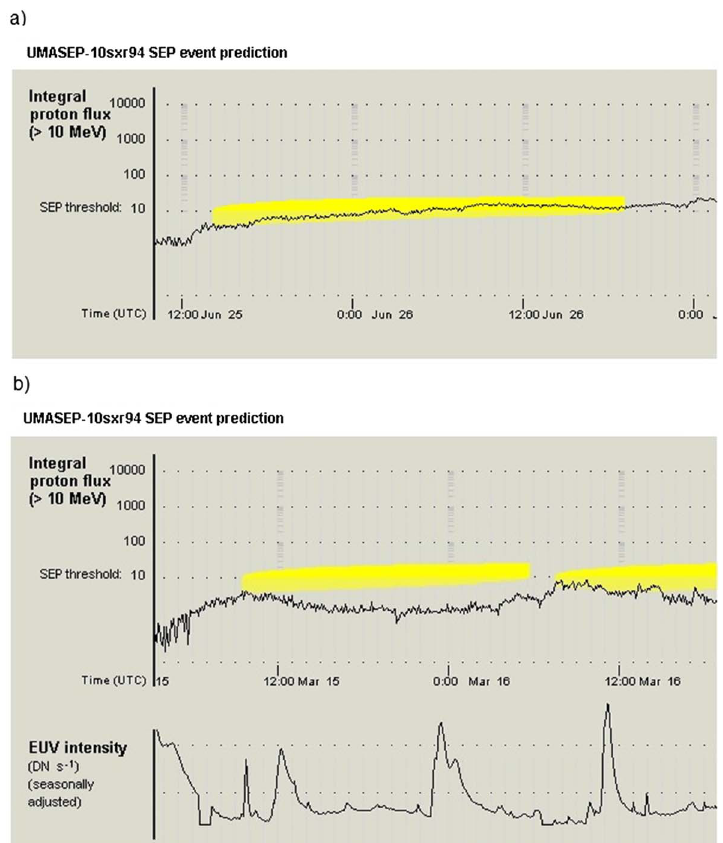
Fig. 6. Examples of predictions made by the PCP model. (a) Presents a successful prediction of the SEP event that took place at 3:50 on June 26, 2015. The warning time was 13 h 50 min. (b) Shows two false alarms issued during March 15 and 16, 2015, a period of high solar activity, as shown in the EUV time series (bottom panel).